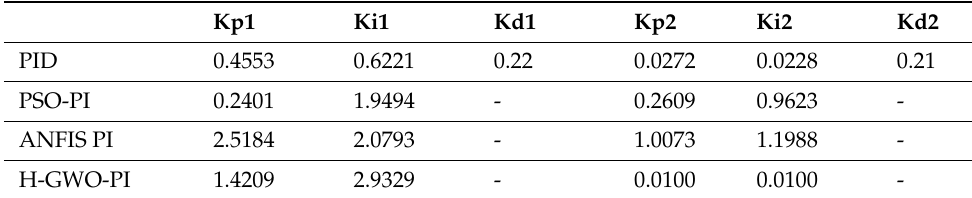
Table 7. PI controller parameter for each Method.